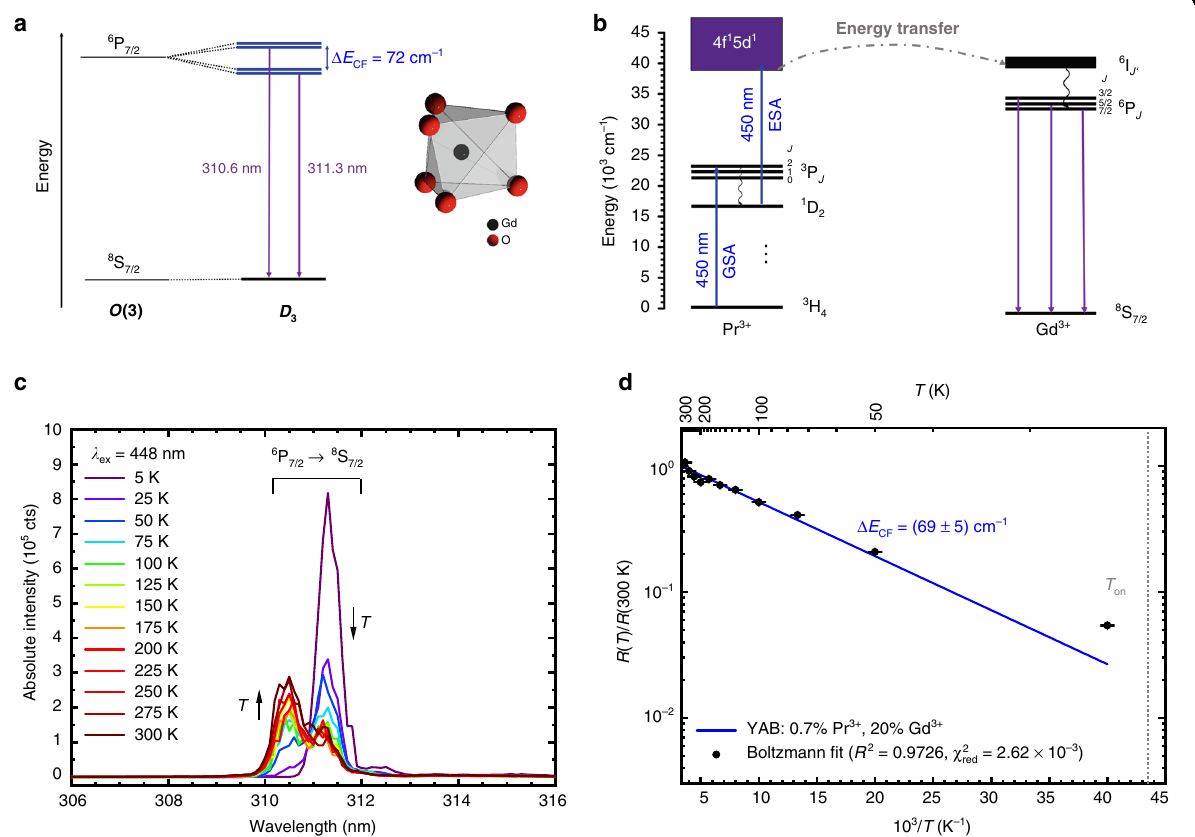
Fig. 2 Thermodynamically optimized Boltzmann cryothermometry with Gd 3 + in YAB:Pr 3 + , Gd 3 + . a Splitting of the lowest excited 6 P 7/2 spin- orbit level of Gd 3 + into the different Kramers ’ doublets at the present D 3 site symmetry in YAB. The doped Gd 3 + ions are sixfold coordinated in the form of a twisted trigonal prism (inset). b Indirect upconversion excitation scheme for Gd 3 + by energy transfer from the 4f 1 5d 1 -related electronic states of Pr 3 + . Both the ground state absorption (GSA) and the excited state absorption (ESA) of two 450 nm photons within the pulse period ( T = 50 ms) of the used pulsed laser source are indicated. c High-resolution upconversion photoluminescence spectra of YAB: 0.7% Pr 3 + , 20% Gd 3 + upon excitation of Pr 3 + at 448 nm showing the temperature dependence of the two radiative transitions from the lower and higher crystal fi eld states of the 6 P 7/2 level. The arrows mark the two thermometrically employed transitions. d Boltzmann plot of the temperature-dependent LIR normalized to its value at 300 K. The fi tted energy gap, statistical fi gures of merit, and expected onset temperature for Boltzmann behaviour (see Eq. (5)) are